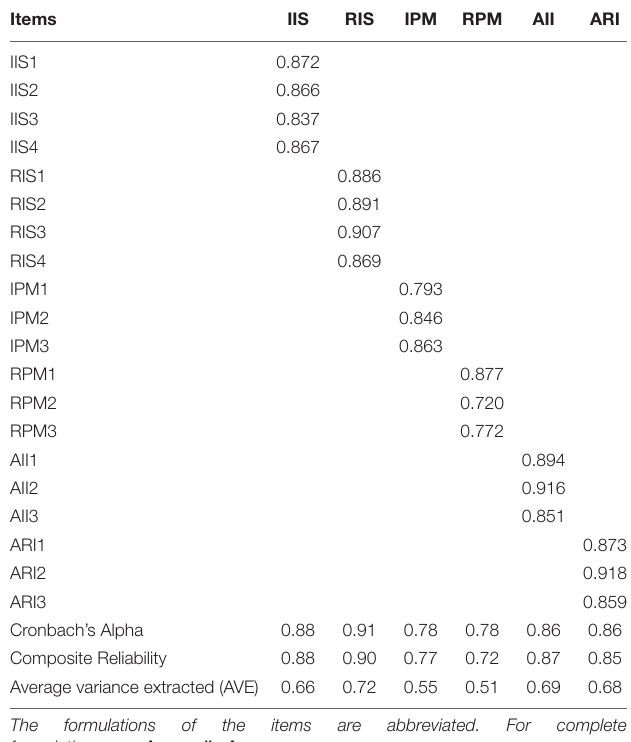
TABLE 2 | Results of confirmatory factor